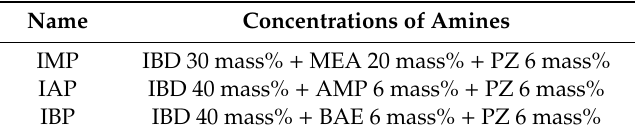
Table 2. Amine types and concentrations of the investigated amine blends.